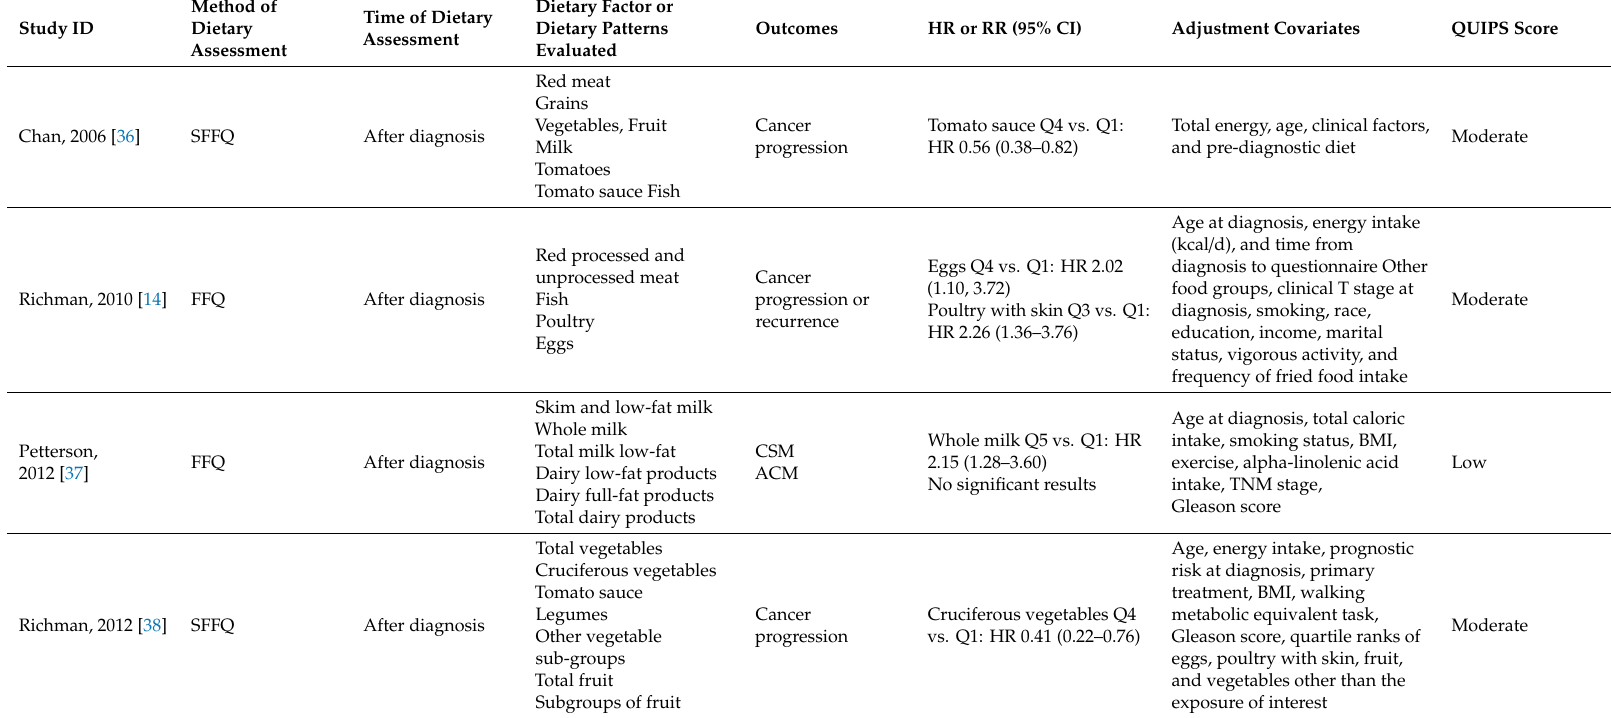
Table 4. Summary of results of included studies regarding prostate cancer. Statistically significant ( p < 0.05) results (HR or RR; 95% CI) are